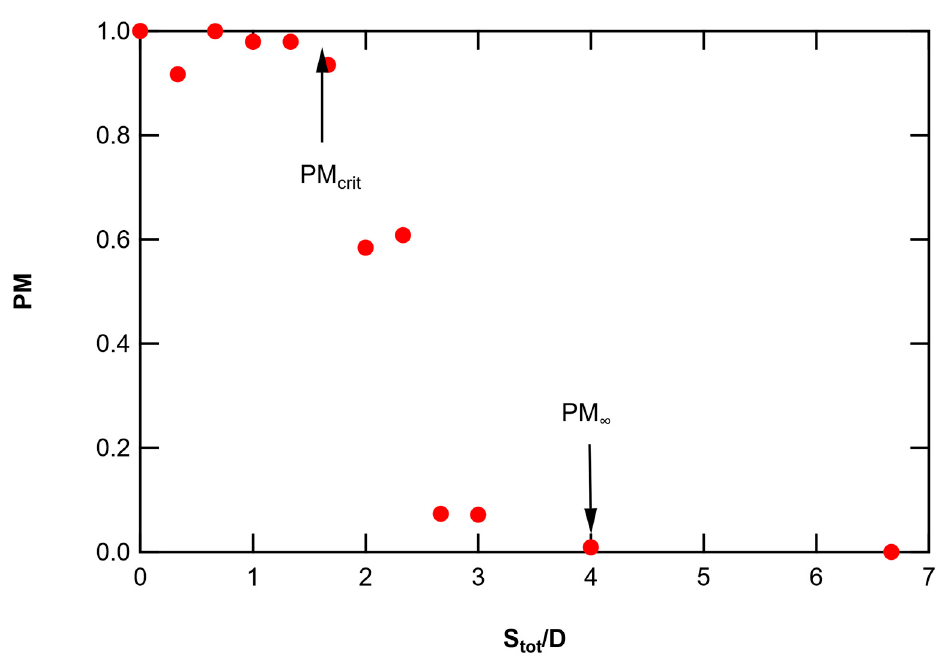
Figure 7. Probability of merging (PM) for two pads separated only by horizontal distance.